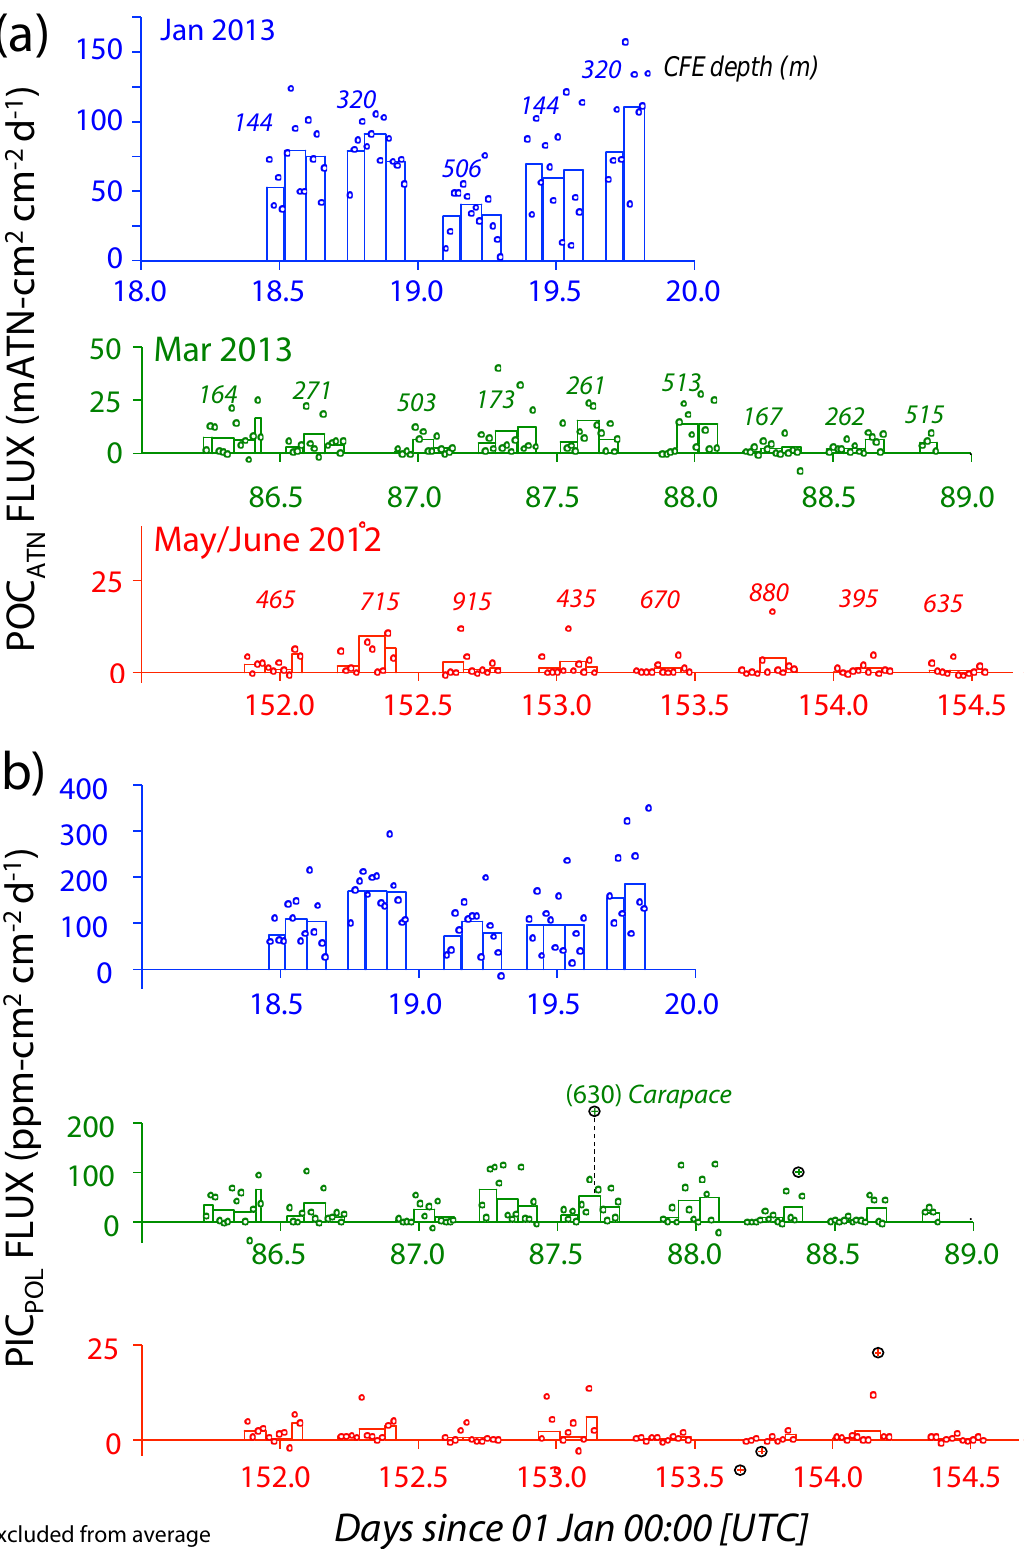
Figure 5. POC ATN (a) and PIC POL (b) flux systematics from CFE deployments in the Santa Cruz Basin. CFE depths are shown in italics in (a) . Bars and small circles denote average flux over 1.8 and 0.3h intervals,